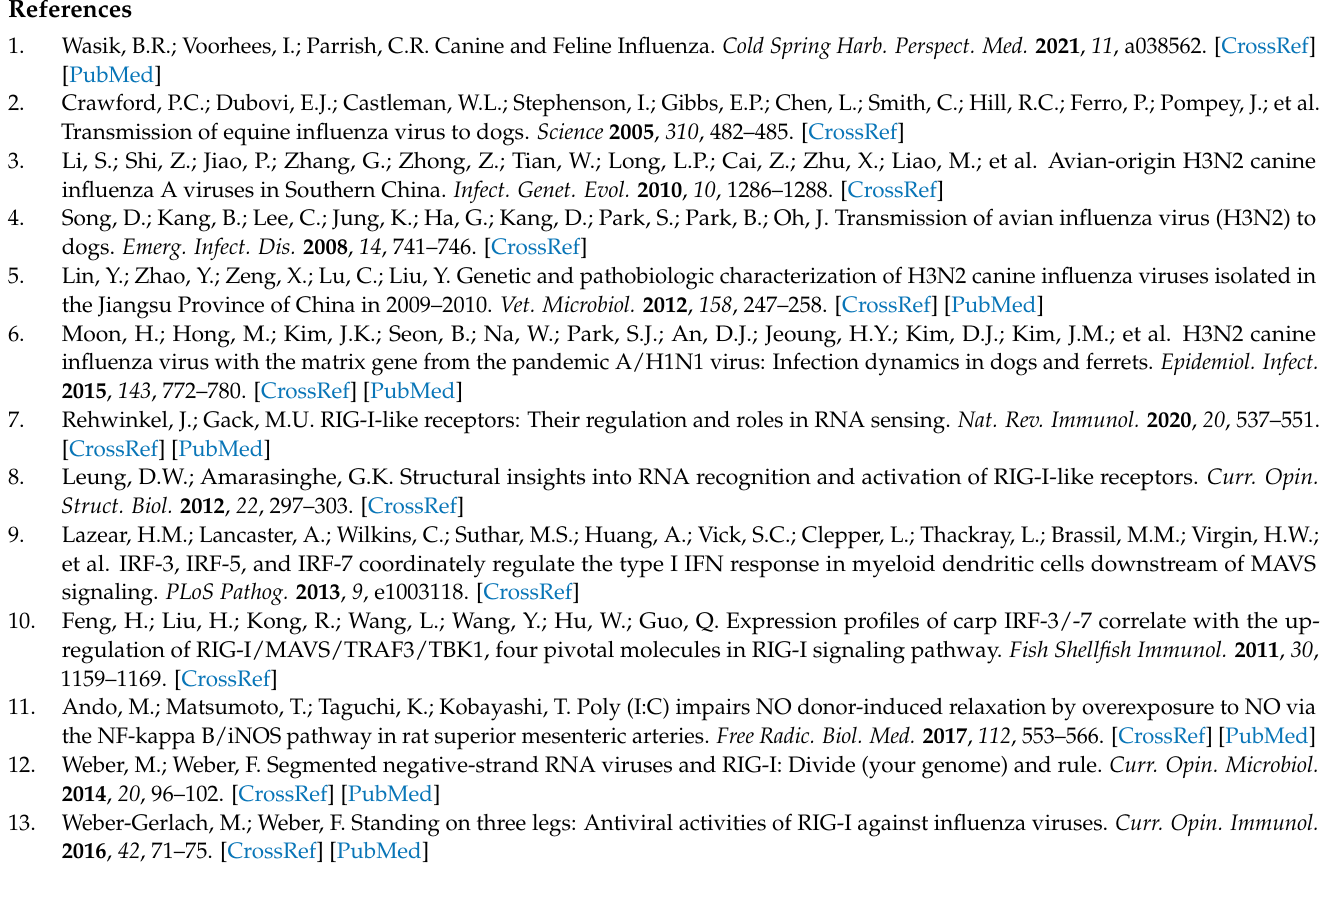
Table S4: Antibody used in this